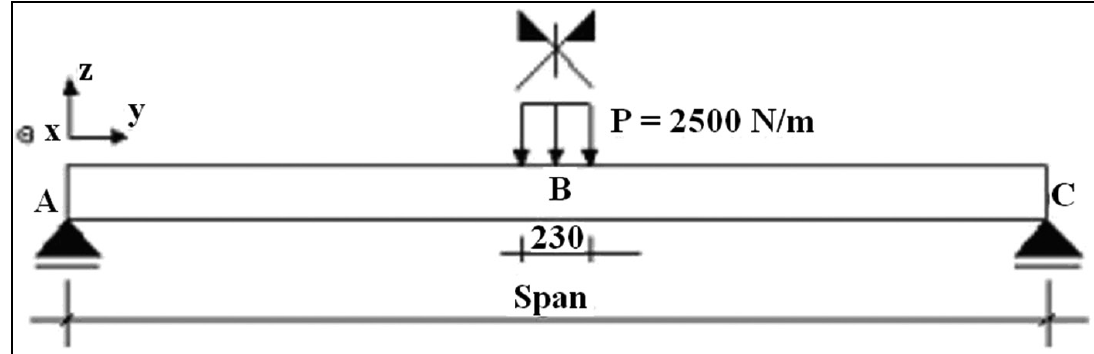
Figure 3. Support and load conditions for the models analyzed under bending.